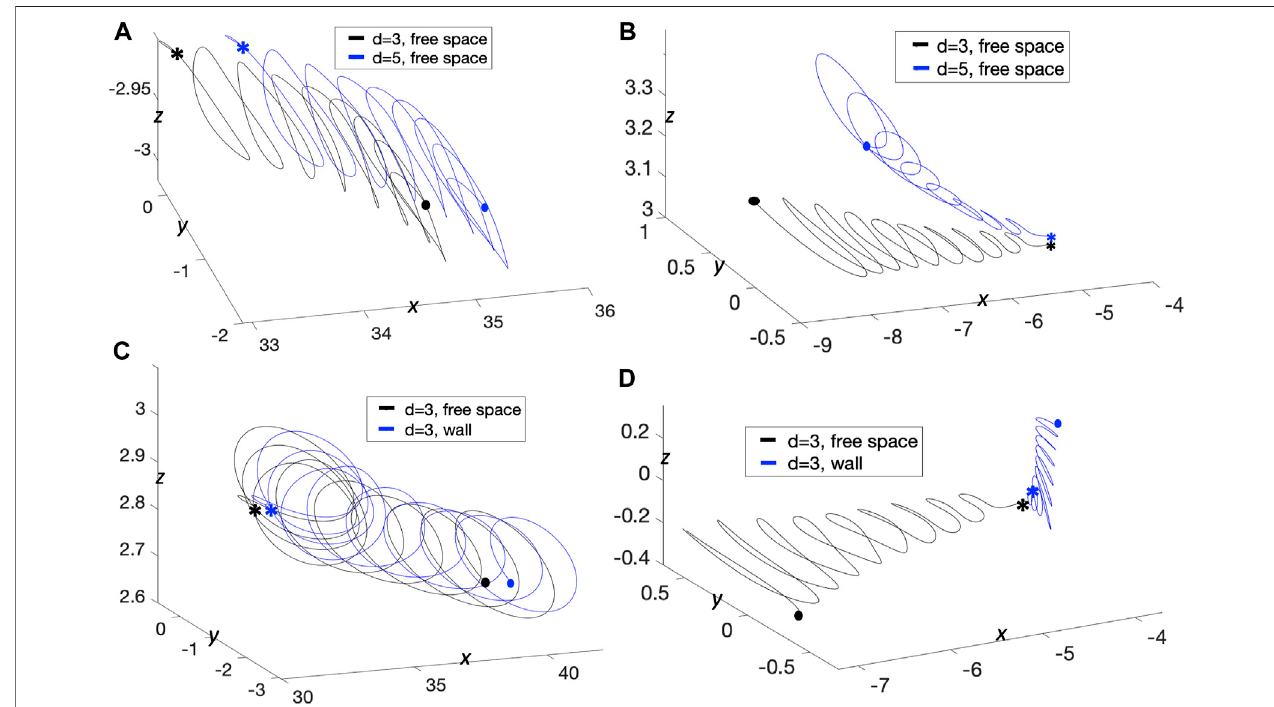
FIGURE 8 | Trajectories with Parallel Sperm. Resulting trajectories for passive fl uid markers as a result of the motion of sperm initialized in parallel planes with preferred planar beat forms. (A , B) Free space case with swimmers initialized d (cid:1) 3, 5 μ m apart. Initial locations of fl uid markers in (A) are (33, 0, − 2.9) and (33.6, 0, − 2.9) andinitializedat( − 4.8,0,3.02)and( − 4.8,0,3.04)in (B) ,for t (cid:1) 0 – 0.4775 s. (C , D) Comparingtrajectorieswithandwithoutawallwithswimmersinitialized d (cid:1) 3 μ mapart. Initiallocationsof fl uidmarkersin (C) are(32.84,0,2.82)and(33.28,0,2.82)andinitializedat( − 4.2,0, − 0.1)and( − 4.12,0, − 0.04)in (D) ,for t (cid:1) 0 – 0.4325 s.Starting (cid:129) locations are denoted with * and ending locations are denoted with